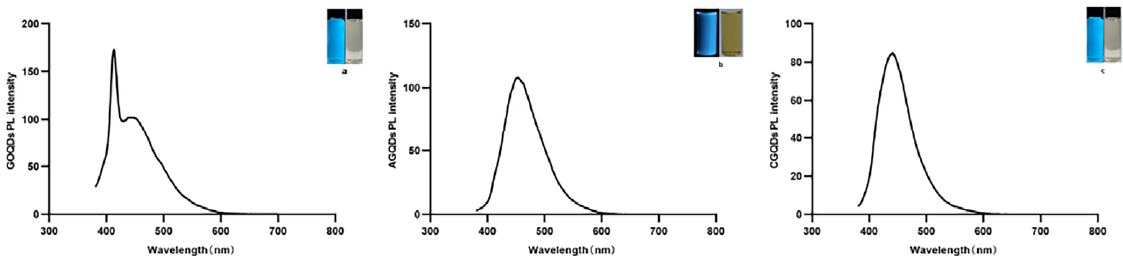
Figure 2. PL spectrum of Graphene Quantum Dots powder dispersed in water. ( a ) Photos of GOQDs solution at 365 nm UV lamp (left) and under natural light (right). ( b ) Photos of AGQDs solution at 365 nm UV lamp (left) and under natural light (right). ( c ) Photos of CQQDs solution at 365 nm UV lamp (left) and under natural light (right).